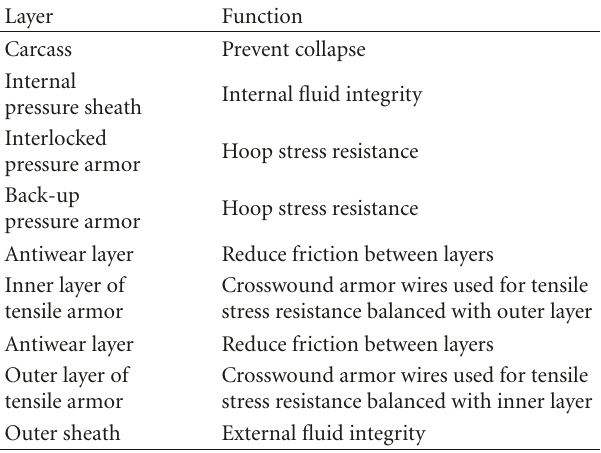
Table 1: Layers’ functions.